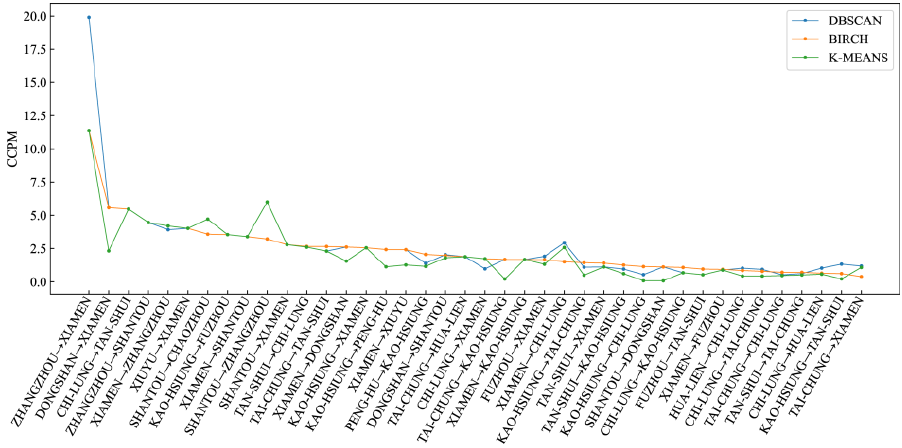
Figure 14. Comparison of DBI evaluation indices for different clustering algorithms.